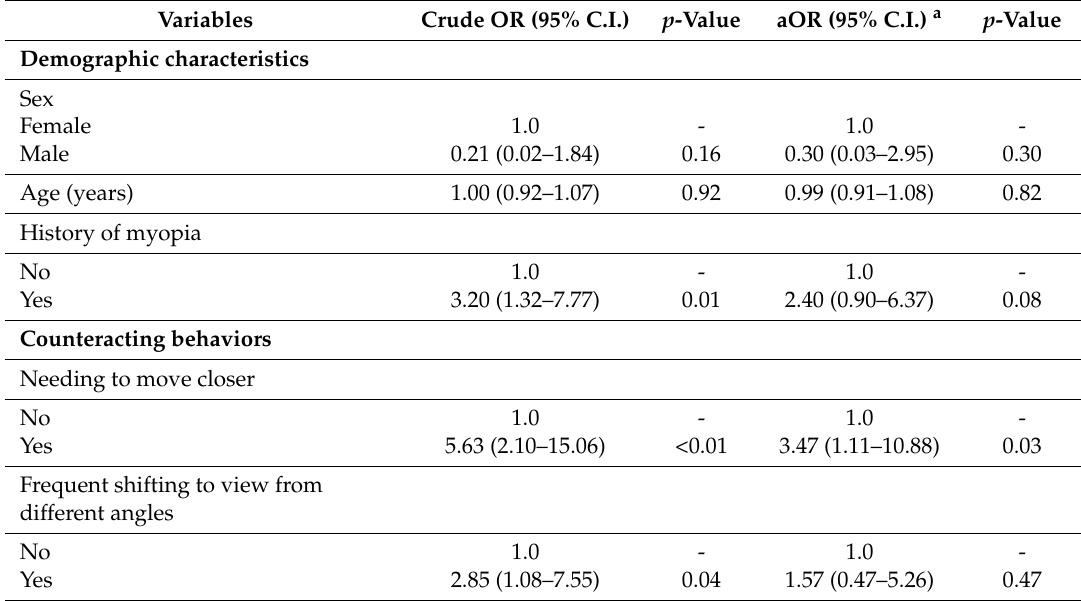
Table 3. Univariate and multivariate logistic regression analysis of factors influencing dry eye symptoms.